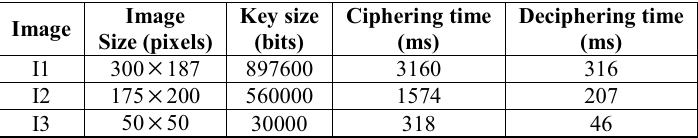
Table 4. Results obtained by